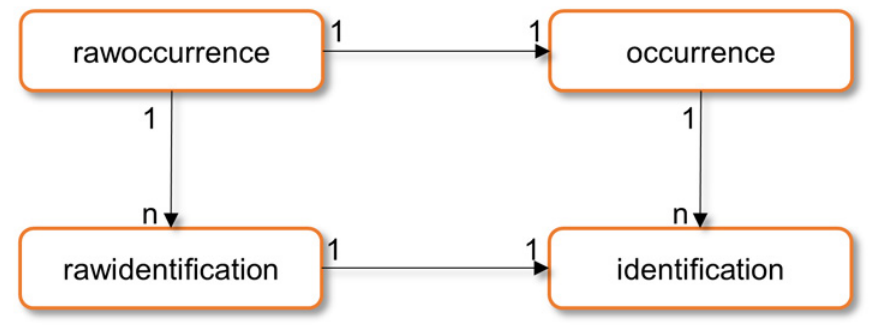
Fig 2. Principal model of raw and improved data in the B-HIT database. Corresponding raw and improved table (i.e. identification from the provider and improved identification) are linked through a 1 – 1 relation. Multiple identifications can be associated to a single record and are therefore linked through a 1-n relation with the (raw) occurrence table.